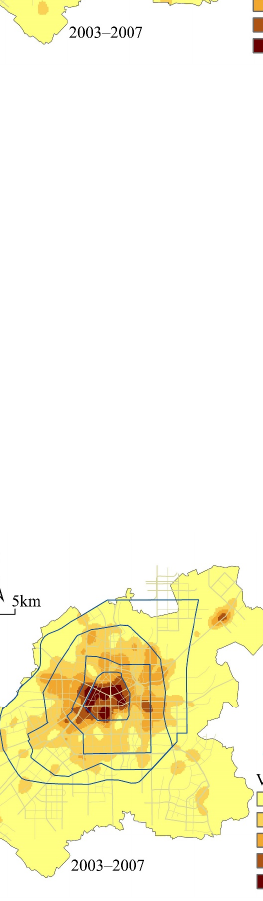
Figure 5. Overall characteristics of the kernel density of functional urban land conversion. This figure is the kernel density map of the total conversion area of the four types of functional urban land, including the area of “convert in” and “convert out”, so the kernel density value is greater than that of a certain type of functional urban land.